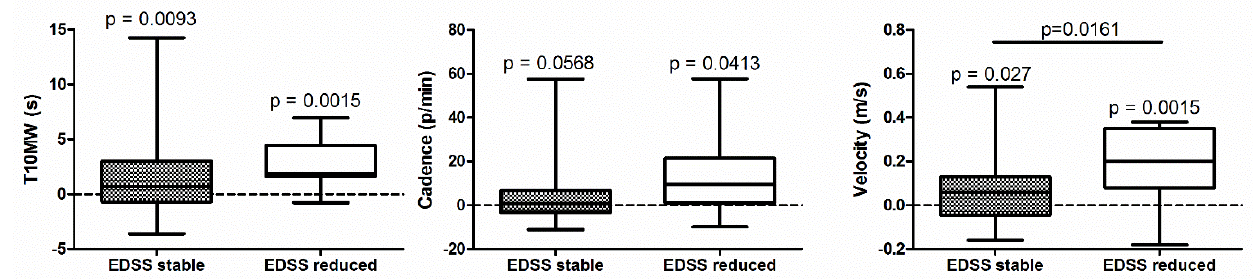
Figure 1. Changes in clinical (Timed 10-m Walking test—T10MW) and instrumented gait measures (cadence and velocity, measured with inertial sensors) in patients with stable (grey, N = 29) and reduced (white, N =11) EDSS after intensive neurorehabilitation. Data are presented as difference with respect to the baseline, with positive values indicating improvement. p values: one-sample t -test versus zero (above each box) or independent heteroscedastic t -test (above the line).